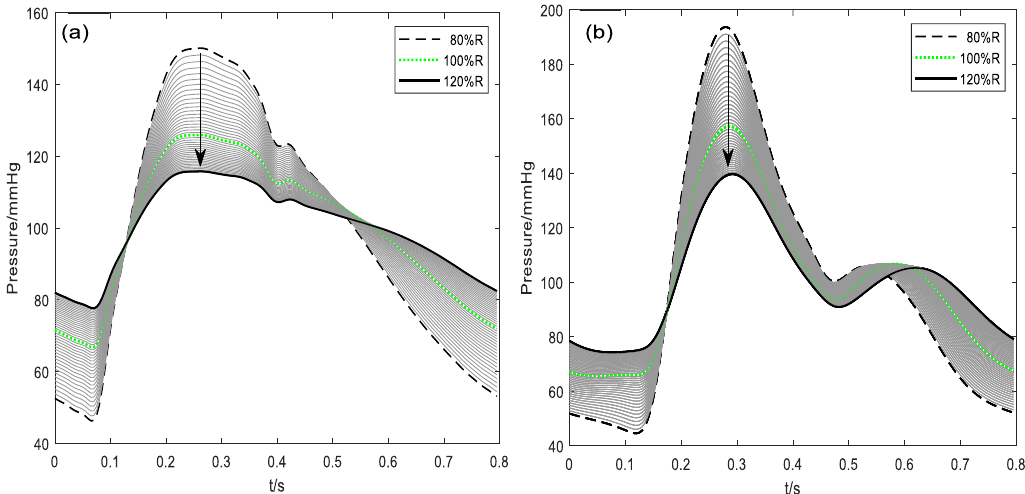
Figure 1. Effect of varying the model vessel radii on the morphology of the pulse waveform: ( a ) Right carotid artery, ( b ) right femoral artery. 80% R , 100% R and 120% R denote the minimum, starting and maximum radius, respectively. The arrows indicate the effect of increasing vessel radius. The x-axis is normalised